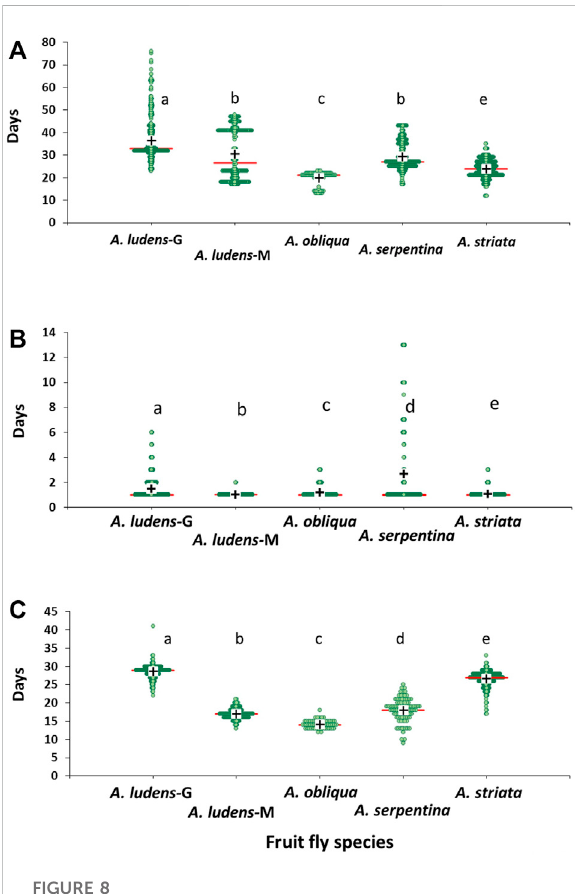
FIGURE 8 Development time in days of immature stages of four Anastrepha species reared under fi eld conditions (A) Egg-third instar larvae; (B) Third instar larvae-pupae; (C) Pupation period. Green points show dispersion data, red horizontal lines show the median and black crosses the mean of days. A. ludens -G (from grapefruit), A. ludens -M (from